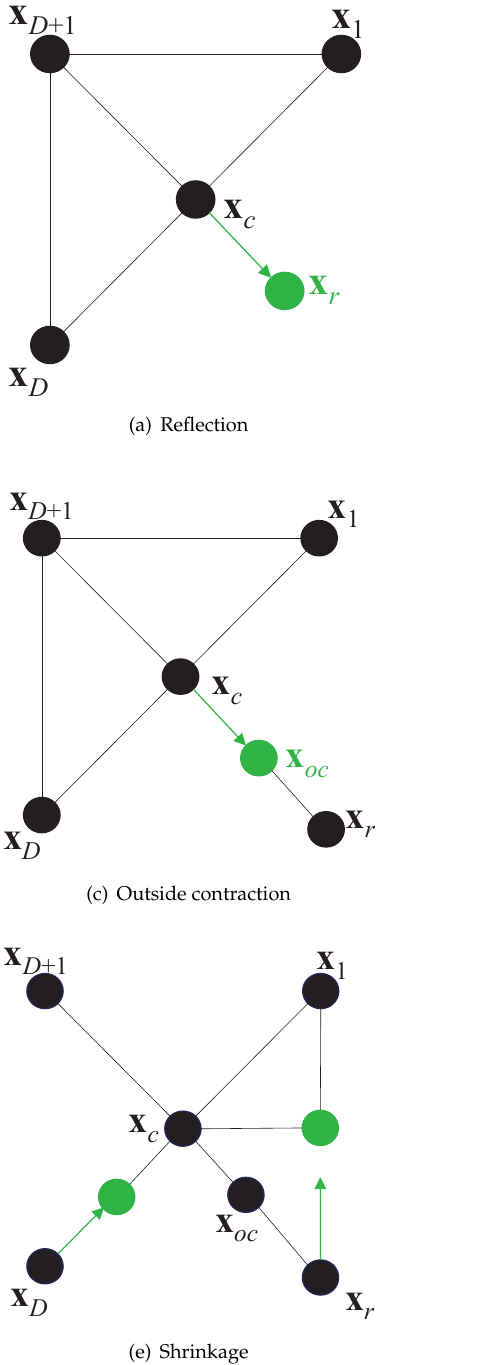
Figure 1. The geometric transformations in an NM simplex